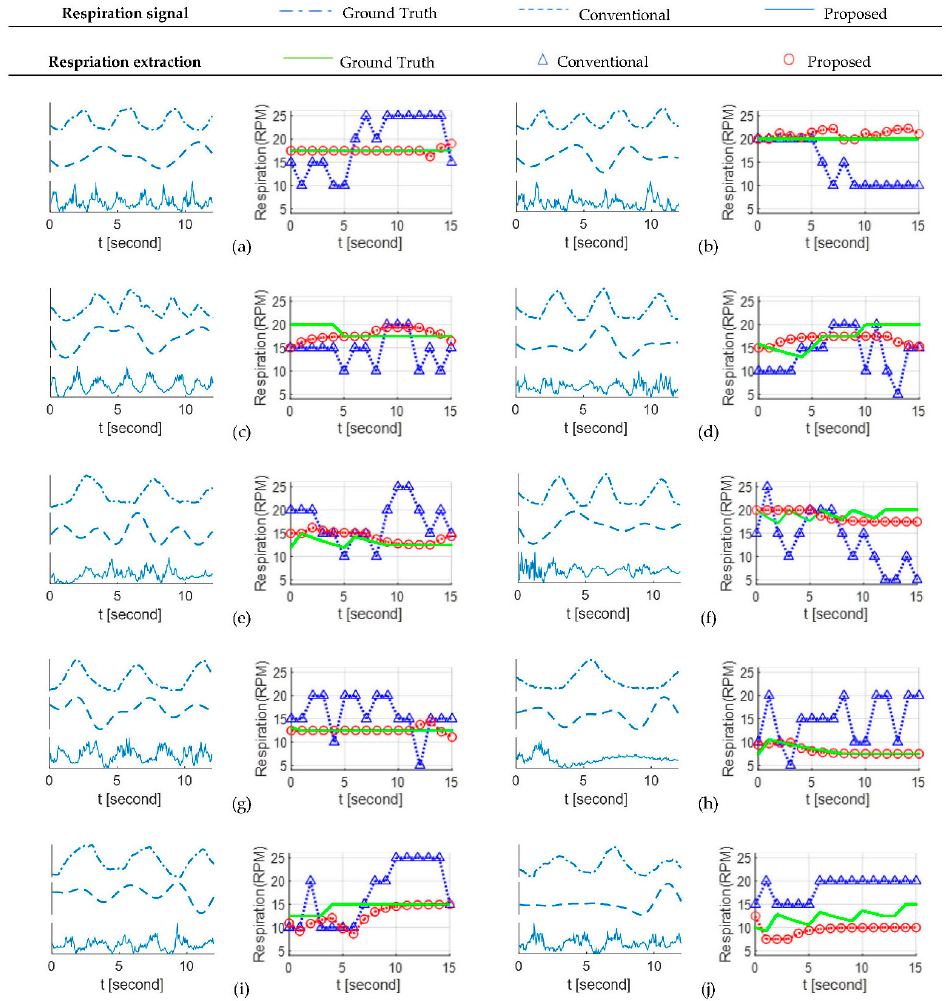
Figure 11. Respiration extraction results for the case shown in Figure 5d. ( a ) Subject #1, ( b ) Subject #2, ( c ) Subject #3, ( d ) Subject #4, ( e ) Subject #5, ( f ) Subject #6, ( g ) Subject #7, ( h ) Subject #8, ( i ) Subject #9, and ( j ) Subject